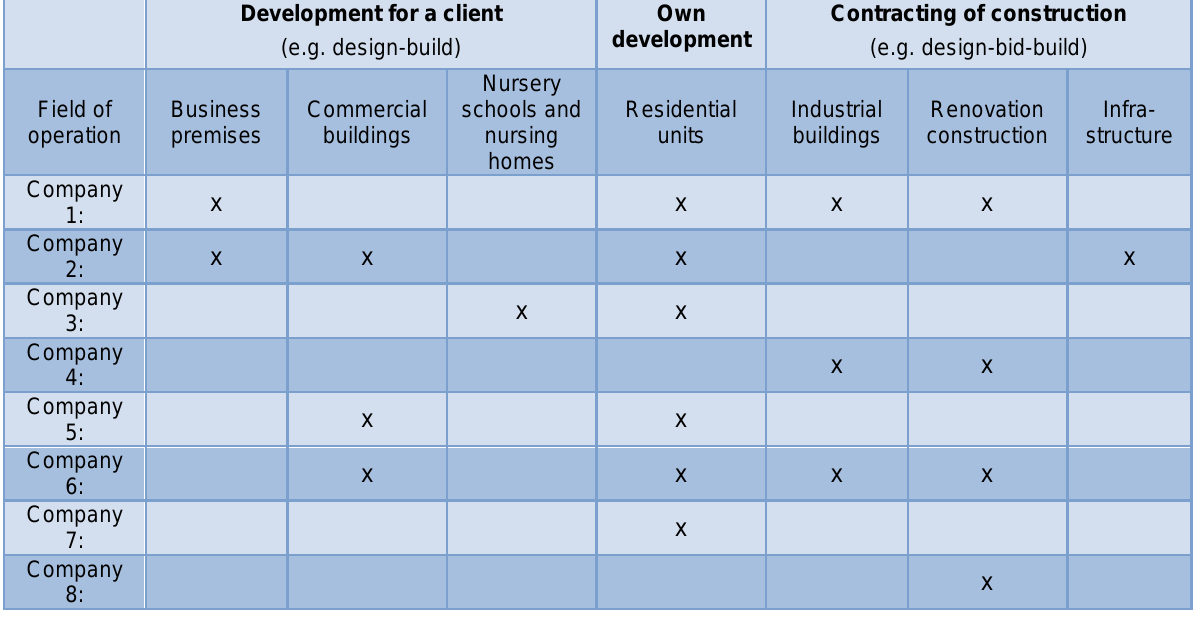
Table 2 The construction companies’ fields of operations Common